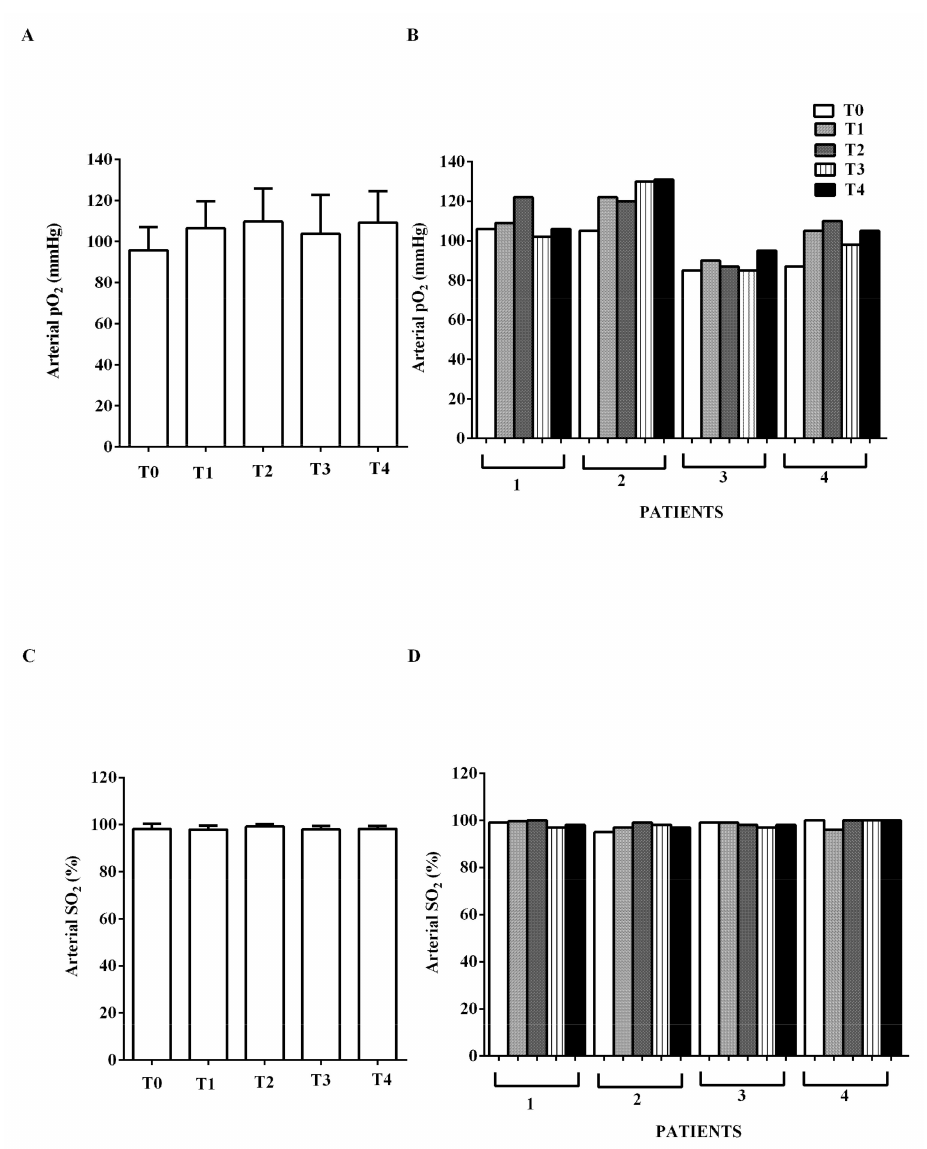
Figure 5. In ( A , B ), e ff ects of levosimendan on arterial partial pressure (pO 2 ) and in ( C , D ), on arterial oxygen saturation (SO 2 ). In A and C, values are means ± SD. In B and D, columns represent single